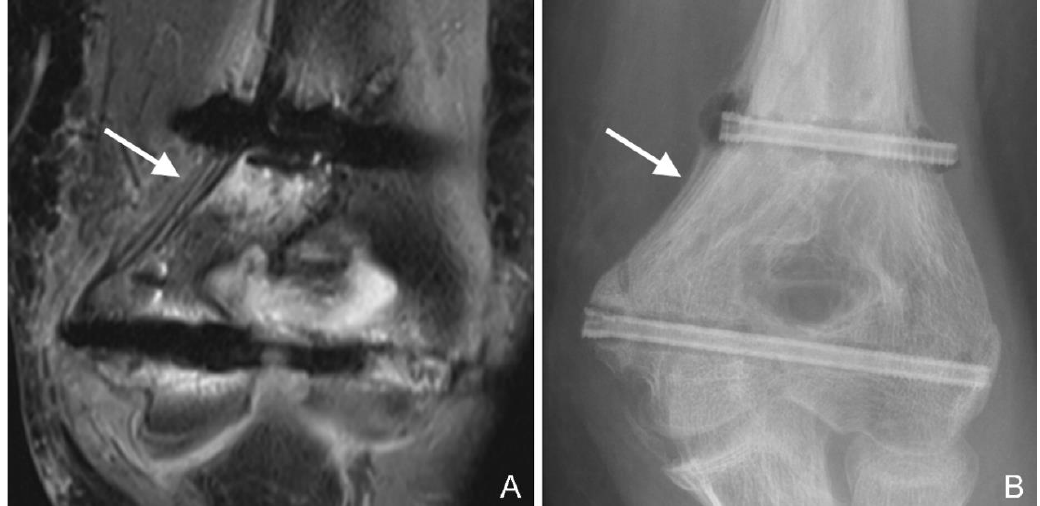
Figure 4. ( A ): PD tse fs (proton density turbo spin echo fat-saturated) coronal image of the left elbow of a 14-year-old boy with an intercondylar humeral fracture. Hypointense layers of ossified periosteal reaction alternate with hyperintense fluid (arrow). Hypointense gas locules along both screws and hyperintense bone marrow edema are also seen. ( B ): Corresponding radiograph. The periosteal reaction is particularly evident near the proximal screw (arrow). The gas locules along the proximal screw and at the screw head are also visible.